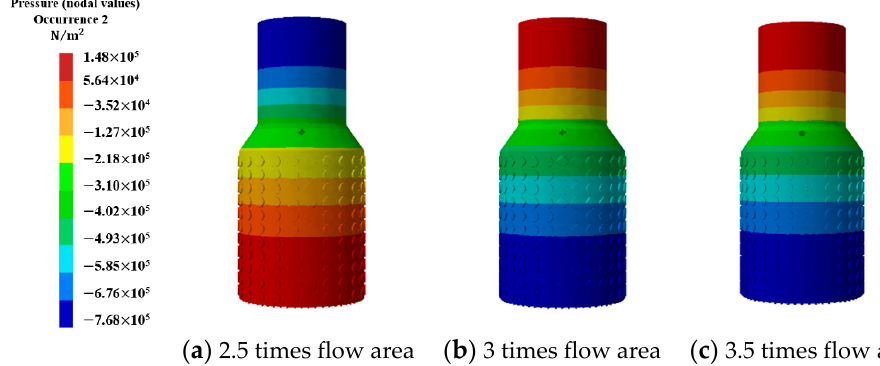
Figure 21. Second-order acoustic cavity modality.